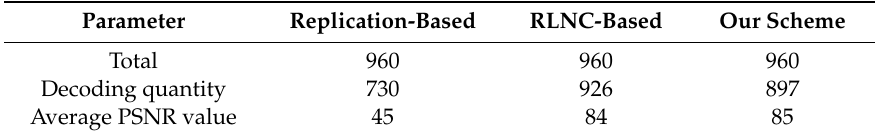
Figure 9. Analysis of video quality.